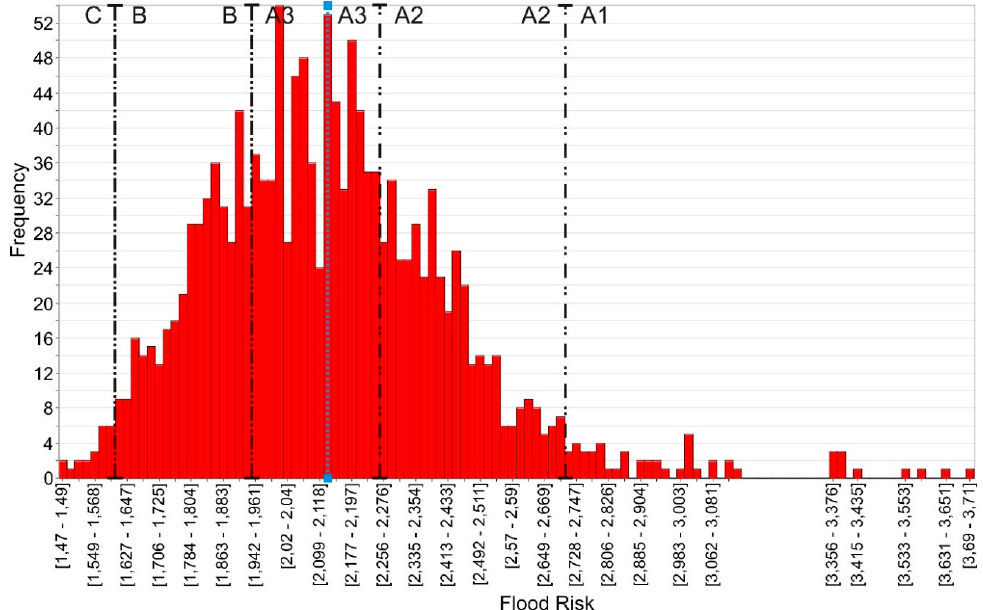
Figure 3. Flood risk values histogram used for risk class thresholds delimitation into the flood risk analysis of the PRICAM project.